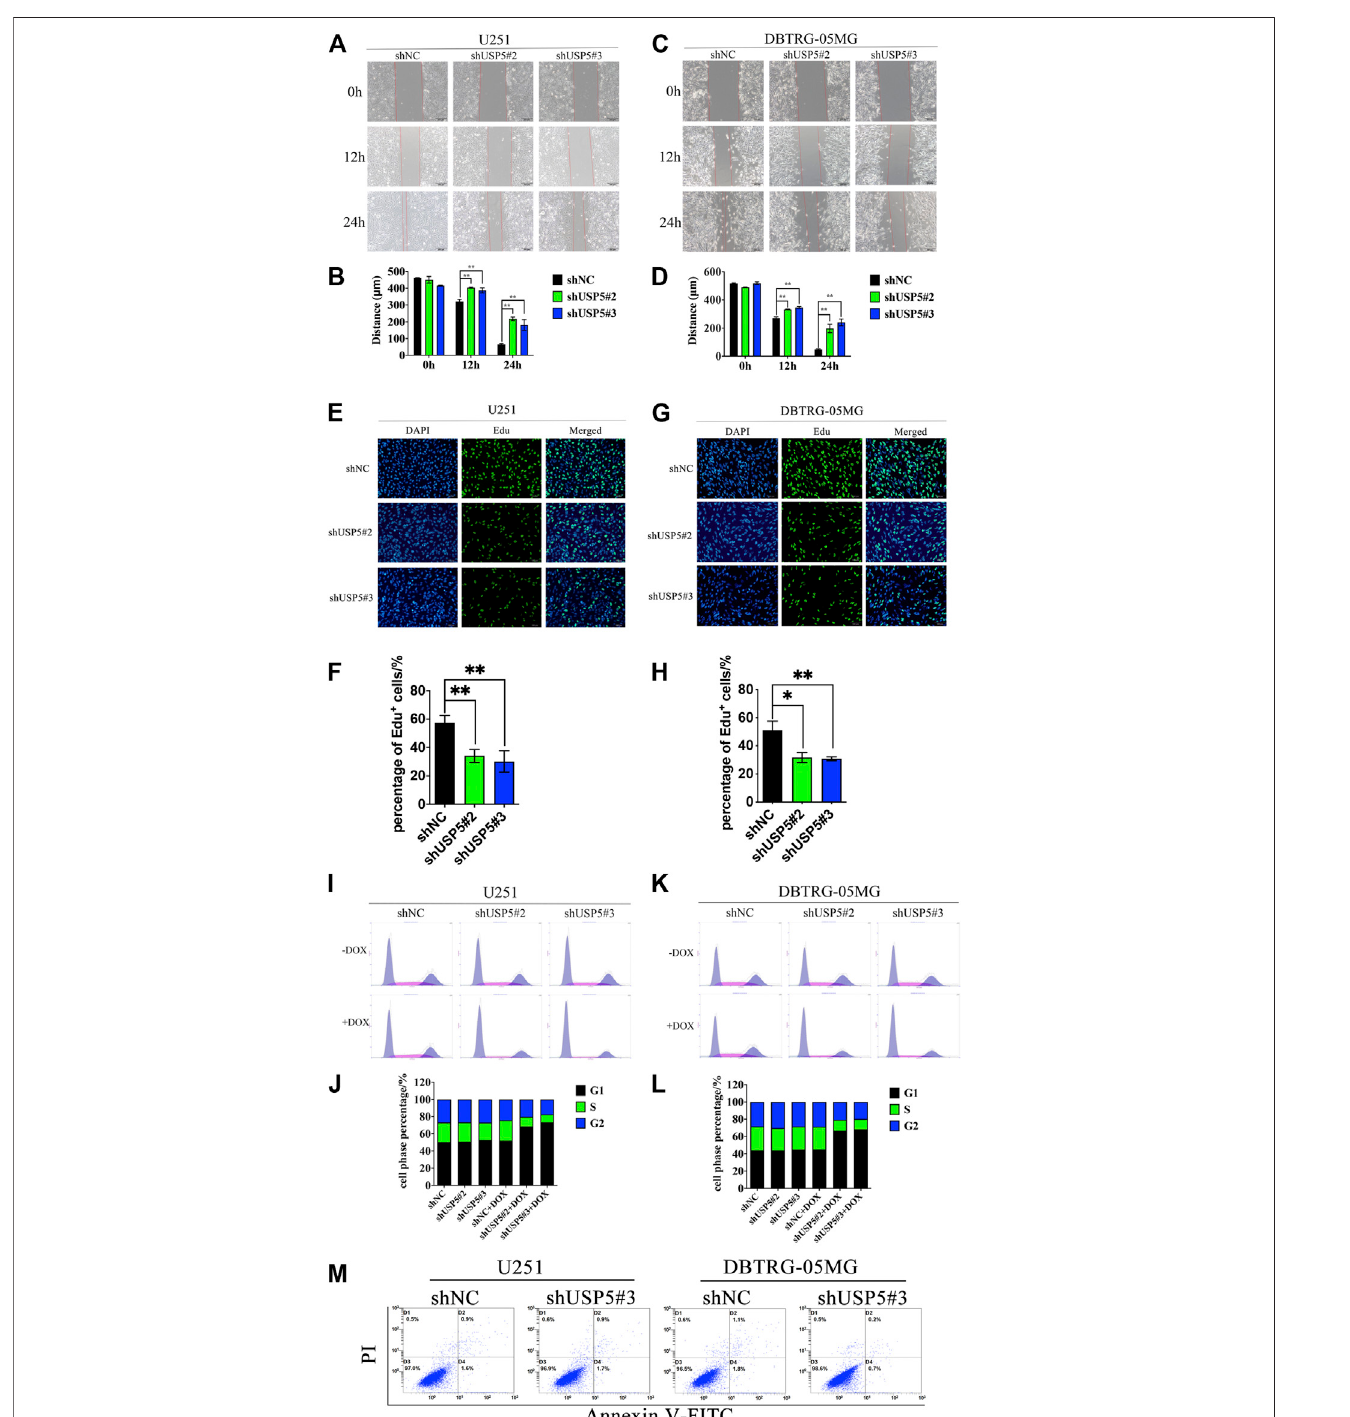
FIGURE2| USP5knockdowninhibitedGBMcellmigrationandinducedcellcyclearrestinG1phase (A – D) U251andDBTRG-05MGcellsstablyexpressed shNC or shUSP5 (#2, #3) were treated with 2 ug/mL DOX for 72 h. Migration of U251 and DBTRG-05MG cells were determined based on a wound-healing assay. Black bar, 200 μ m (E – H) U251and DBTRG-05MGcellsstablyexpressed shNCor shUSP5(#2, #3)weretreatedwith2 ug/mL Doxfor72 h, then cellswereincubated with10 μ M Edu for 2 h. Edu incorporation levels were determined by BeyoClick ™ EdU Cell Proliferation Kit with Alexa Fluor 488. White bar, 100 μ m (I – L) U251 and DBTRG- 05MG cells stably expressed shNC or shUSP5 (#2, #3) were treated with 2 ug/mL DOX (+ DOX) or PBS ( − DOX) for 72 h. Cell cycle distribution of U251 and DBTRG- 05MG cells was assessed by PI staining and fl ow cytometry analysis. Representative graphs and statistical analysis of percentages at different cell cycle stages are shown (M) U251andDBTRG-05MGcellsstablyexpressedshNCorshUSP5#3weretreatedwith2 ug/mLDOX(+DOX)orPBS( − DOX)for72 h.CellapoptosisofU251 and DBTRG-05MG cells was assessed by PI and Annexin V-FITC staining and fl ow cytometry analysis (Data were presented with mean ± SD of three independent experiments, * p < 0.05, ** p <